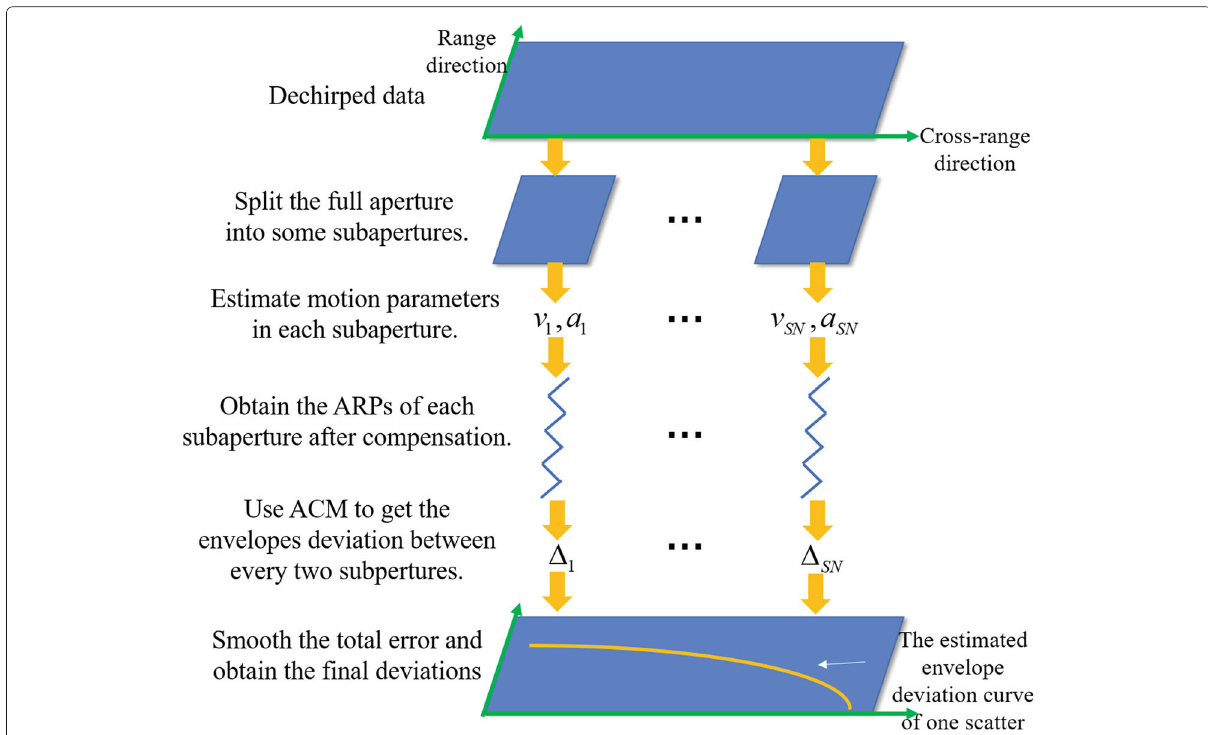
Fig. 2 Framework of the proposed